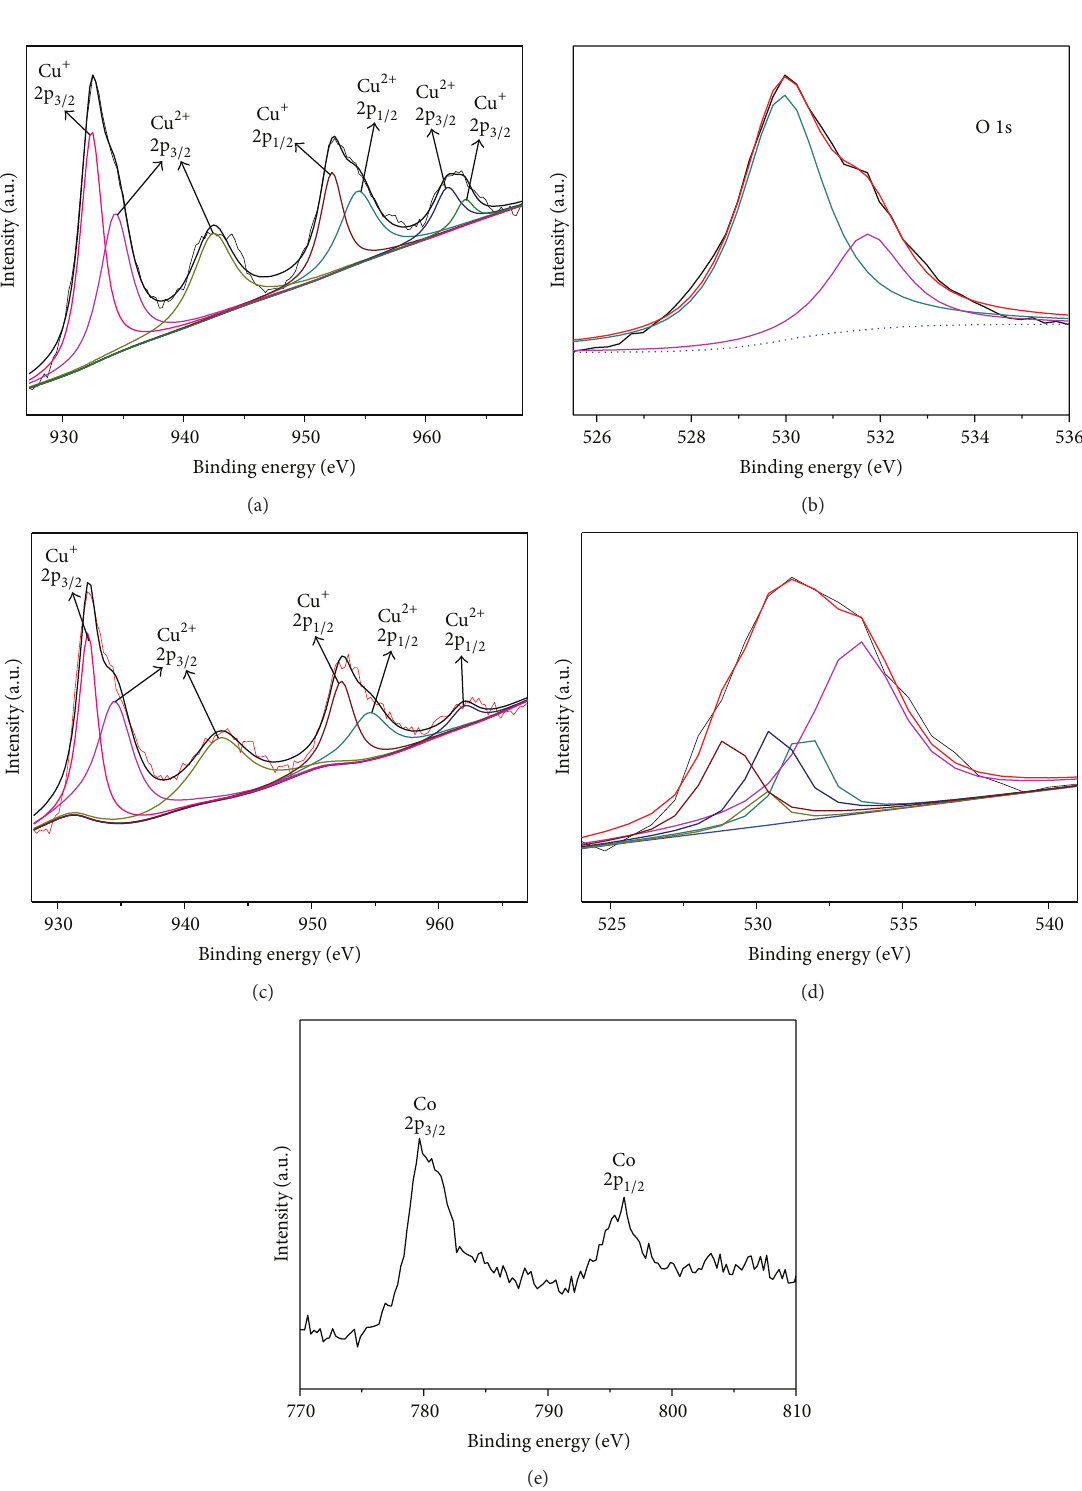
Figure 6: XPS spectra of (a) Cu 2p, (b) O 1s for CuO NRs, (c) Cu 2p, and (d) O 1s for CuO/Co 3 O 4 coaxial heterostructures. (e) 7 XPS spectra of Co 2p for CuO/Co 3 O 4 coaxial